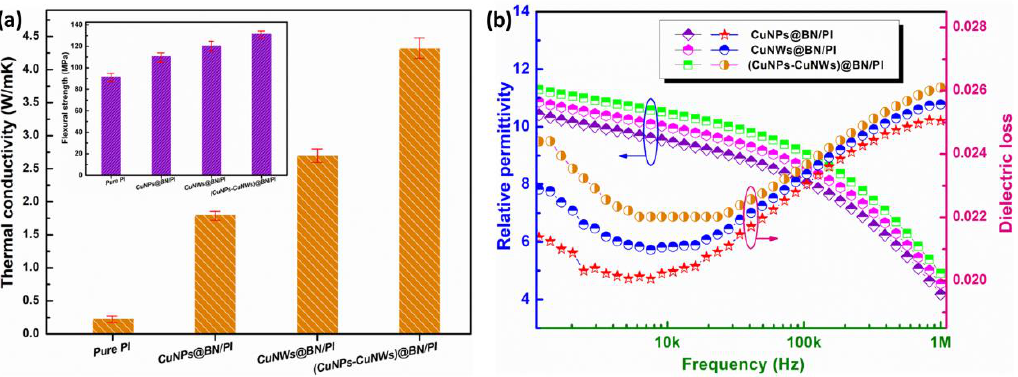
Figure 2. SEM micrographs of ( a ) CuNPs, ( b ) CuNPs@BN, ( c ) (CuNPs-CuNWs)@BN/PI film, ( e ) CuNWs, ( f ) CuNWs@BN, and ( g ) partial magnification of ( c ); TEM images of core-shell CuNPs@BN (inset of ( b ) and CuNWs@BN (inset of ( f ); optical micrographs of pure PI ( d ) and (CuNPs-CuNWs)@BN/PI ( h ) films.